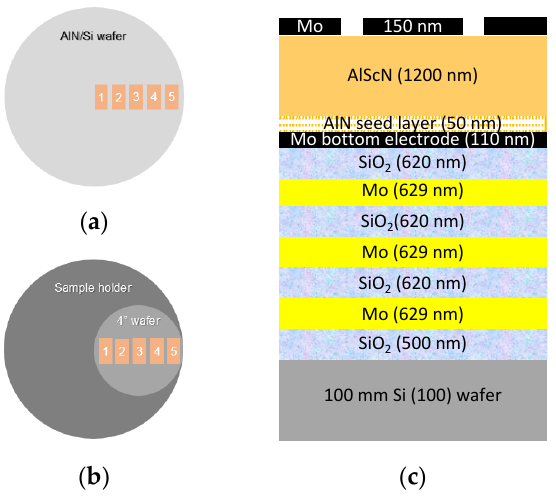
Figure 2. ( a ) Diagram of 8 ‐ inch AlN seed layer/Si wafer used as substrate. Numbers from 1 to 5 represent the spots where the samples were taken from. ( b ) Diagram of the disposition inside the sputtering chamber of the 4 ‐ inch wafer used to fabricate the SMRs. ( c ) Cross section of the manufactured SMRs.